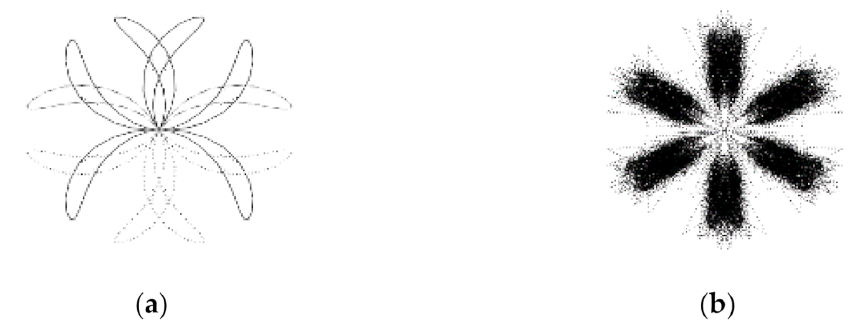
Figure 2. Signal symmetrized dot pattern ( a ) 500 Hz sine wave; ( b ) Random